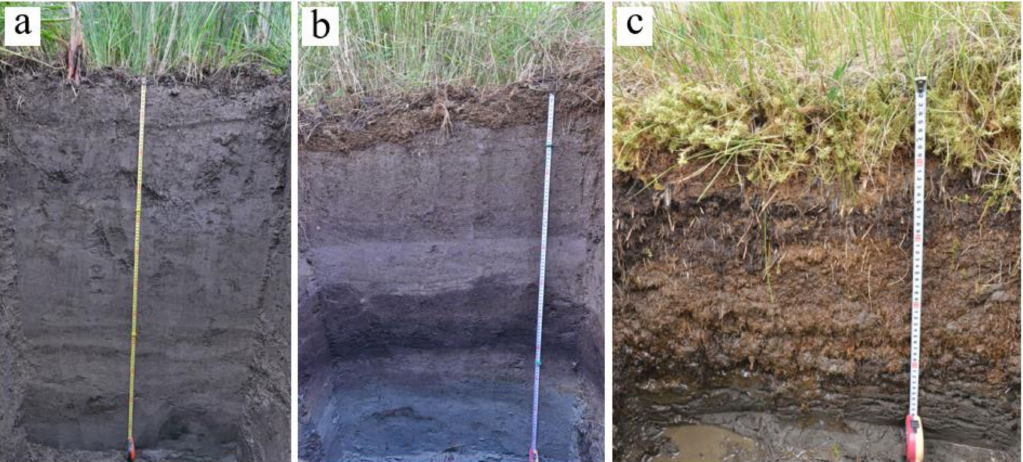
Figure A2. Photos of typical soils of three succession stages: ( a )—Fluvisols (Siltic, Limnic), early successional stage, ALT > 2 m; ( b )—Fluvic Folic Gleysols (Gelic), mid successional stage, ALT near 130 cm; ( c )—Dystric Cryic Histosols, late successional stage, ALT = 50